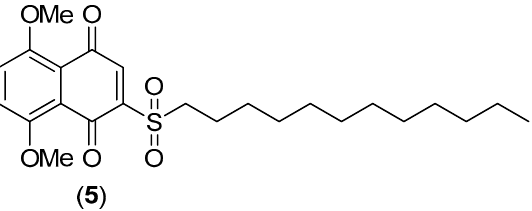
Figure 2. Naphthoquinone containing a sulfone moiety which is of biological significance.